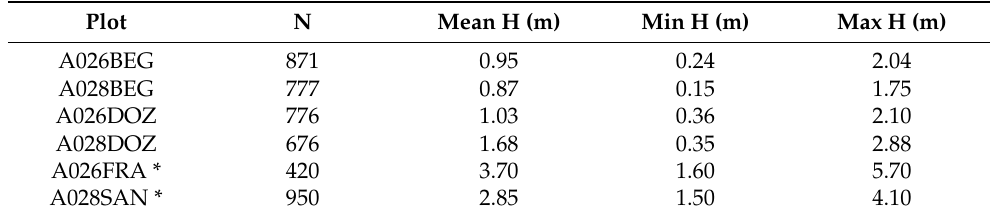
Table 2. Descriptive statistics for the database used in this work (N, number of trees; H, total tree height; mean, average value, min, minimum, max, maximum. In the A026FRA and A028SAN plots, all trees were measured with Haglöf Sweden ® Vertex). Plot N Mean H (m) Min H (m) Max H (m) A026BEG 871 0.95 0.24 2.04 A028BEG 777 0.87 0.15 1.75 776